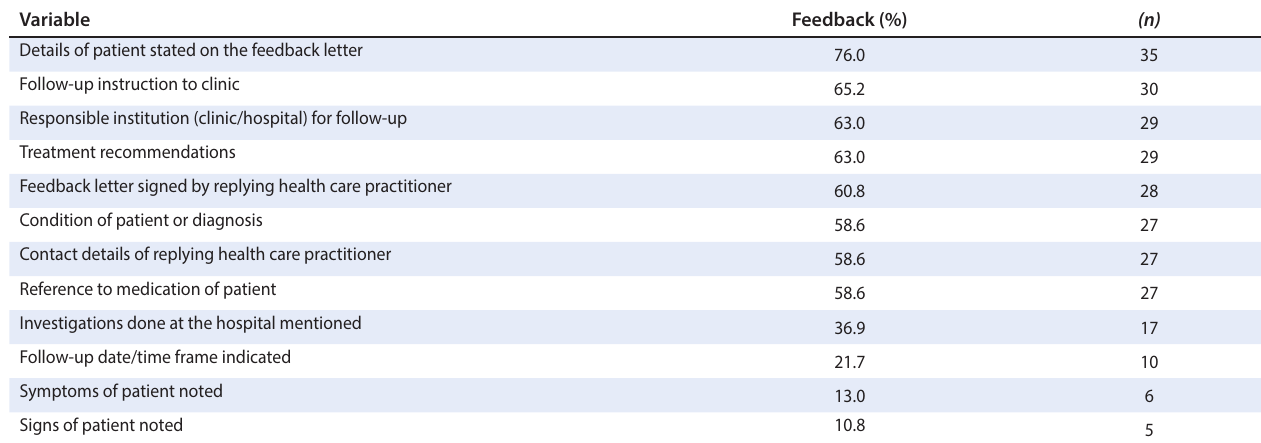
Table 2: Adequacy of the feedback letter ( n =